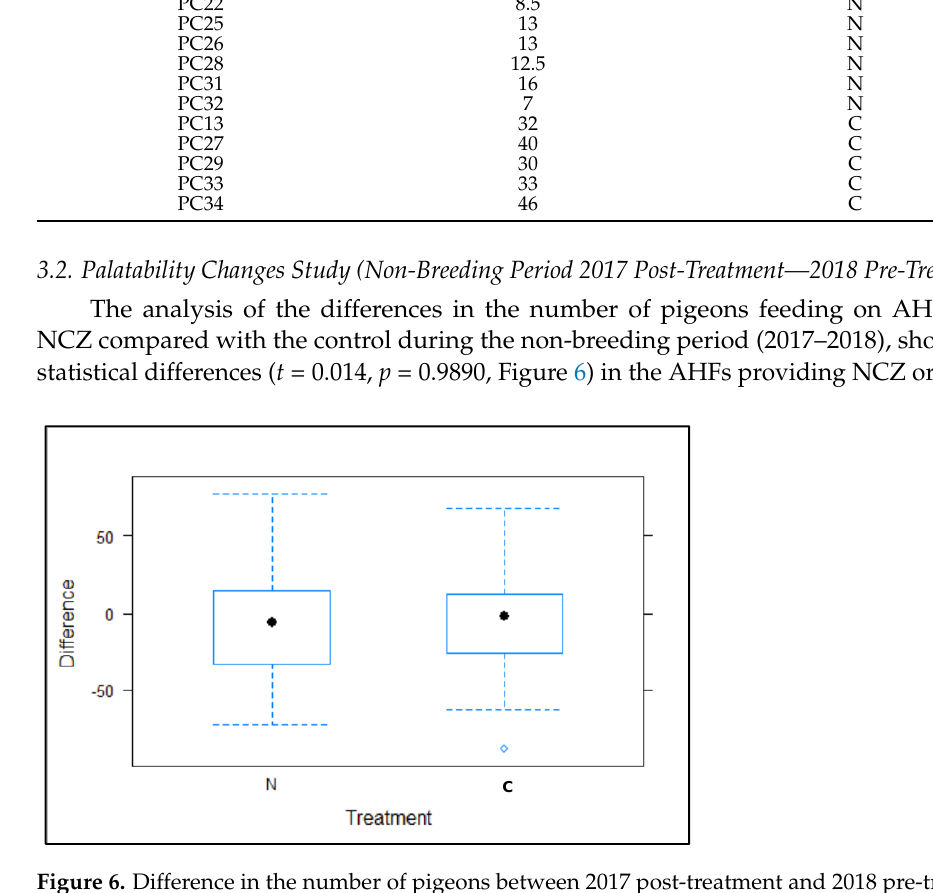
Figure 6. Difference in the number of pigeons between 2017 post-treatment and 2018 pre-treatment periods, according to the test (N, nicarbazin) and control (C, control) groups.